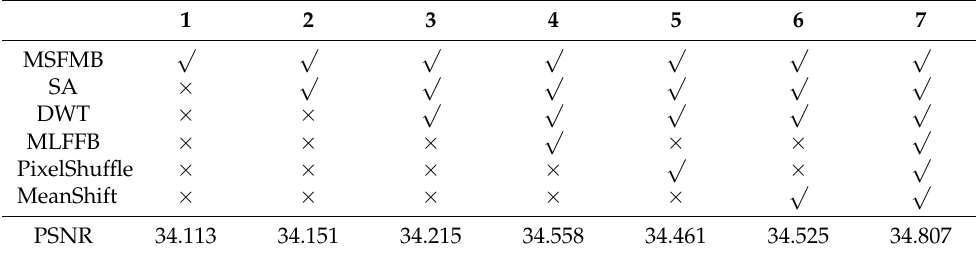
Table 4. Ablation study results on evaluating the efficiency of the network